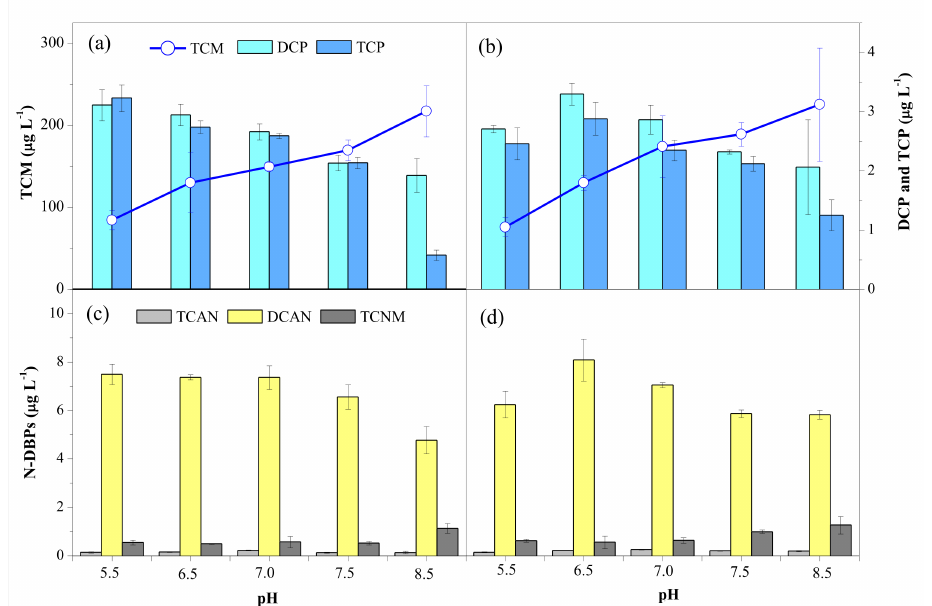
Figure 6. Effect of pH on the formation potential of C-DBPs and N-DBPs: ( a , c ) for PM process; ( b , d ) for PM/BS process. ((HA) o = 3 mg L − 1 , (PM) o = 50 µ M, (BS) o = 250 µ M and pH = 5.5–8.5). Duplicated samples were